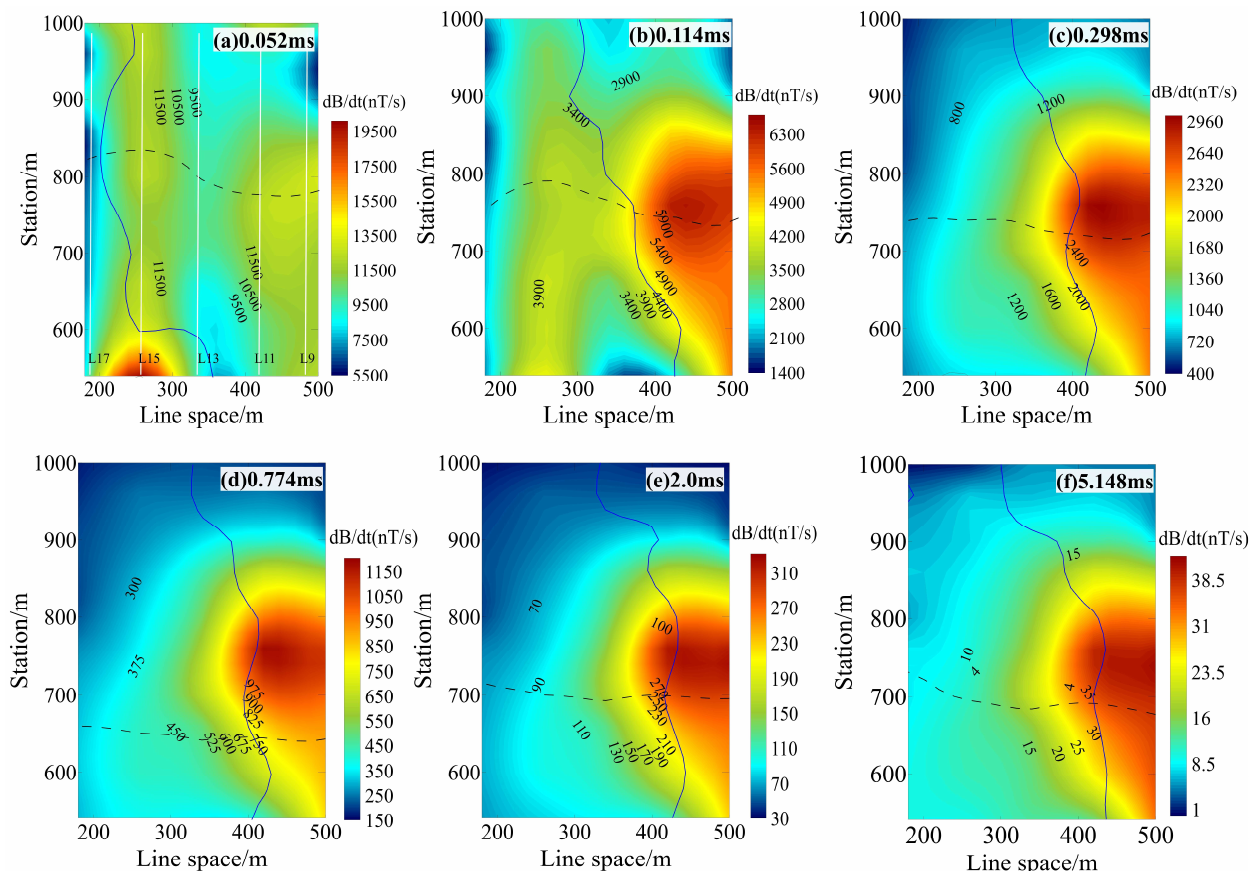
Figure 8. Three-component feature synthesis maps with different sampling times: ( a ) 0.052 ms; ( b ) 0.114 ms; ( c ) 0.298 ms; ( d ) 0.774 ms; ( e ) 2 ms; ( f ) 5.148